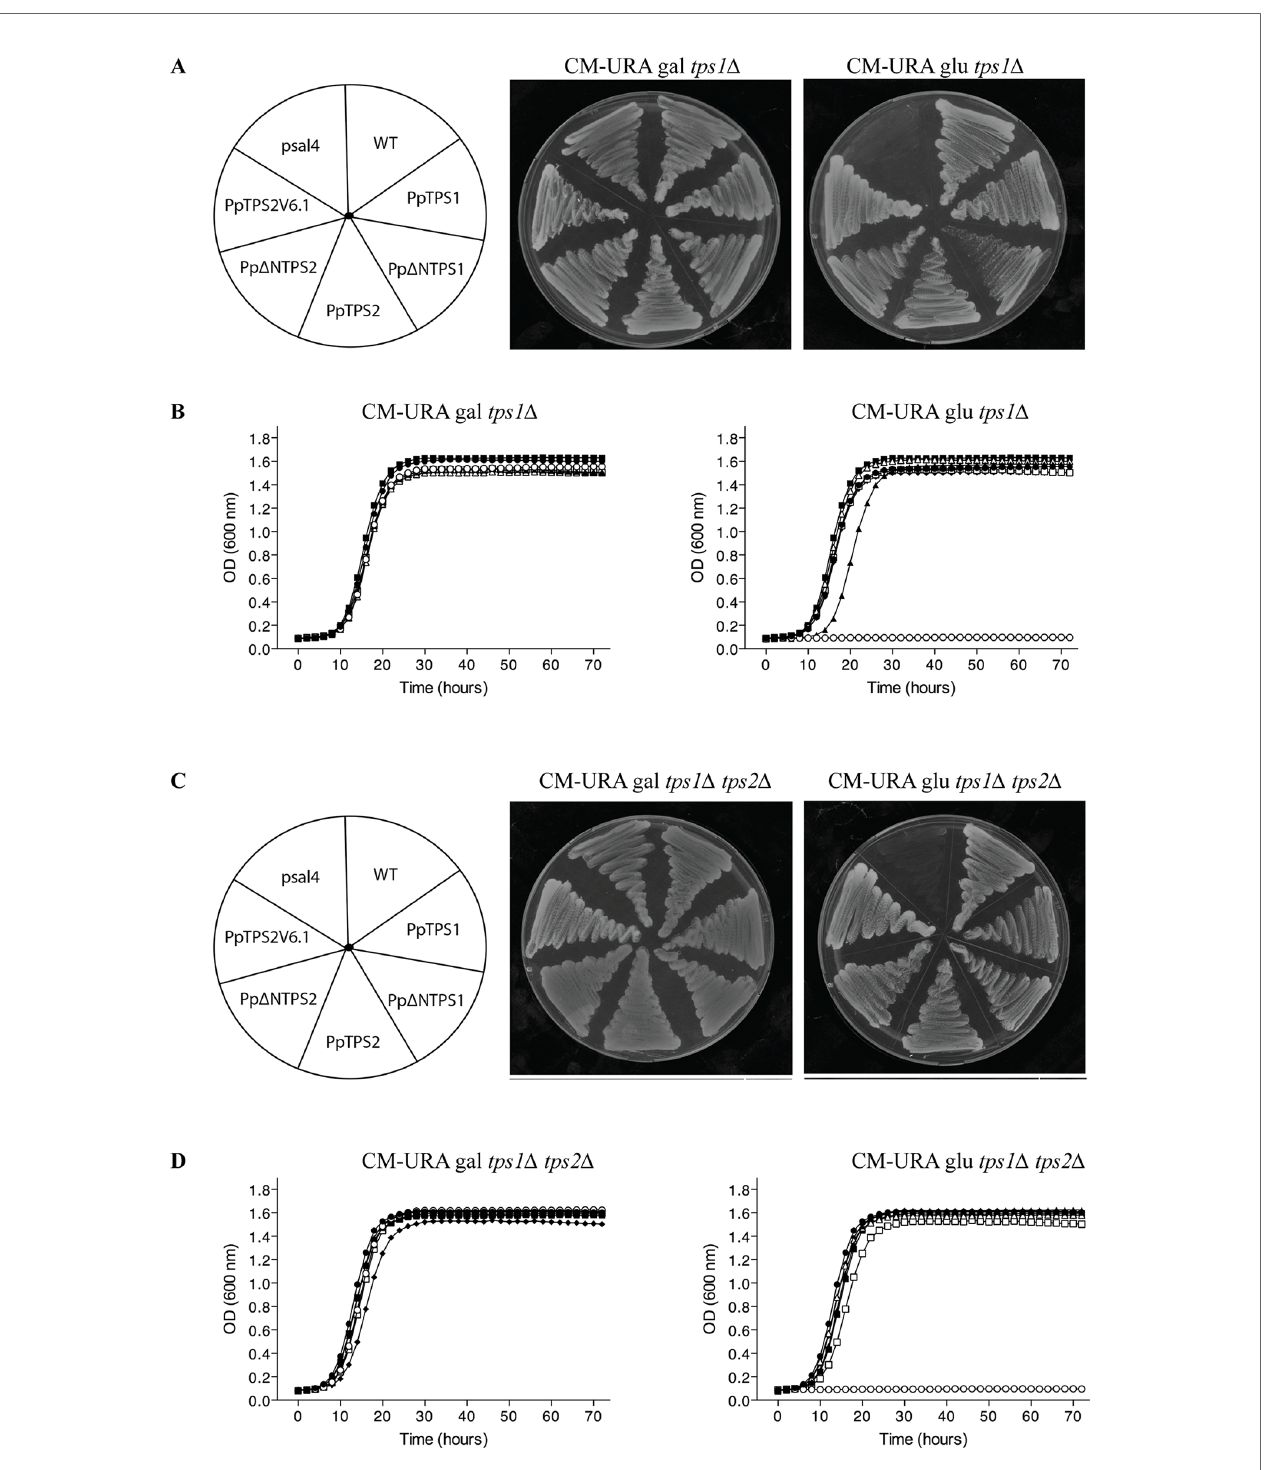
FIGURE 3 | Complementation studies of PpTPS1 , PpTPS2 , and PpTPS2V6.1 in the yeast tps1 Δ (A and B) and tps1 Δ tps2 Δ (C and D) mutants. (A and C) Complementation assay was performed on plates with galactose or glucose. Copper sulfate was added to a fi nal concentration of 100 m M to induce expression. The wild-type yeast strain transformed with the empty vector was used as a control (WT). (B and D) Bioscreen analysis was done in liquid synthetic medium lacking uracil with galactose or glucose and 100 m M copper sulfate. Wild-type (WT) strain transformed with pSAL4 ( ● ), the deletion strain transformed with pSAL4 ( ○ ), or PpTPS1 ( ▲ ), or PpTPS2 ( △ ), or Pp Δ NTPS1 ( ■ ), or Pp Δ NTPS2 ( □ ), or PpTPS2V6.1 ( ◆